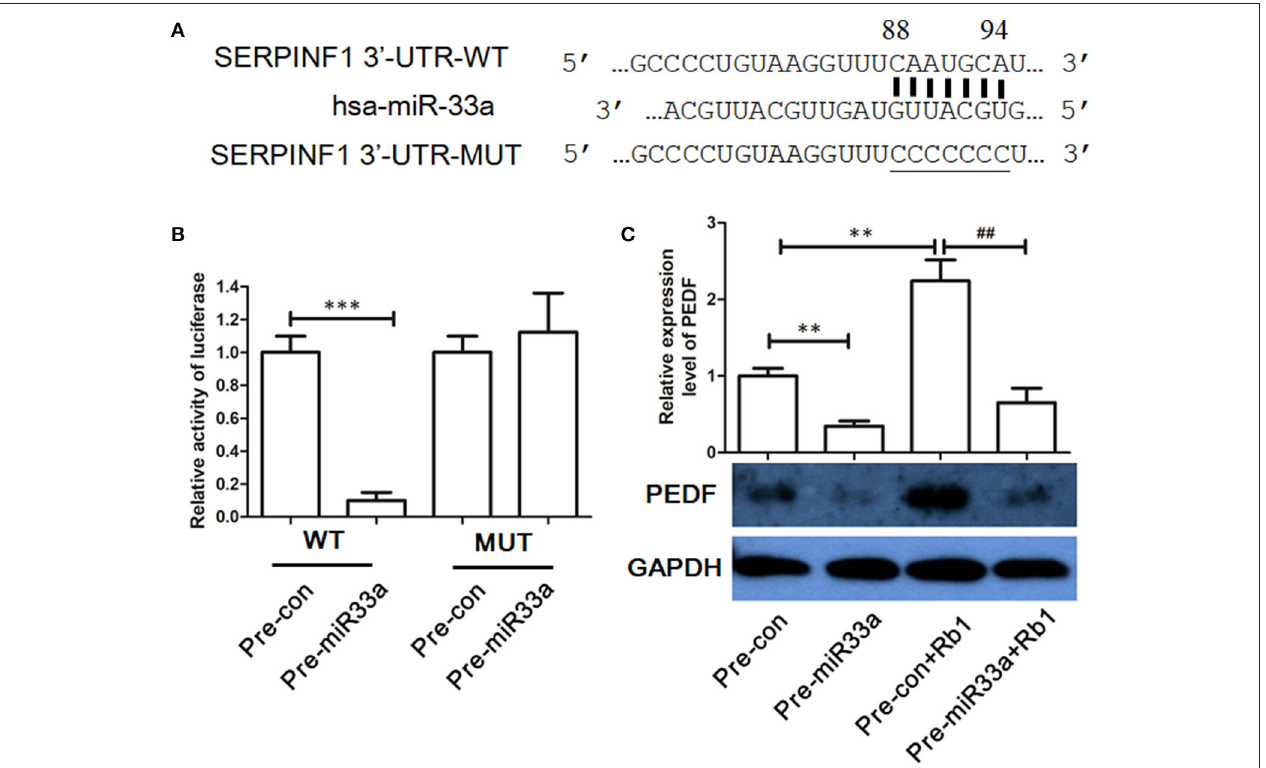
FIGURE 2 | Identification of PEDF as target gene of miR-33a. (A) The predicted binding site in the 3 ′ -UTR of PEDF (SERPINF1) and the mutated region of the predicted binding site. (B) miR-33a mimic (50nM) or nontargeting control (50nM) was cotransfected with the luciferase reporter carrying wild type-PEDF 3 ′ -UTR or mutated PEDF 3 ′ -UTR. Twenty-four hours after transfection, luciferase activities were measured ( n = 3). (C) Western blot analysis and quantification of PEDF expression in Rb1-treated HUVECs with or without miR-33a transfection. Each value was expressed as fold of control mean + S.EM. ( n = 3). **vs. con p < 0.01; ***vs. con p < 0.001; ## vs. Rb1 treatment alone p <